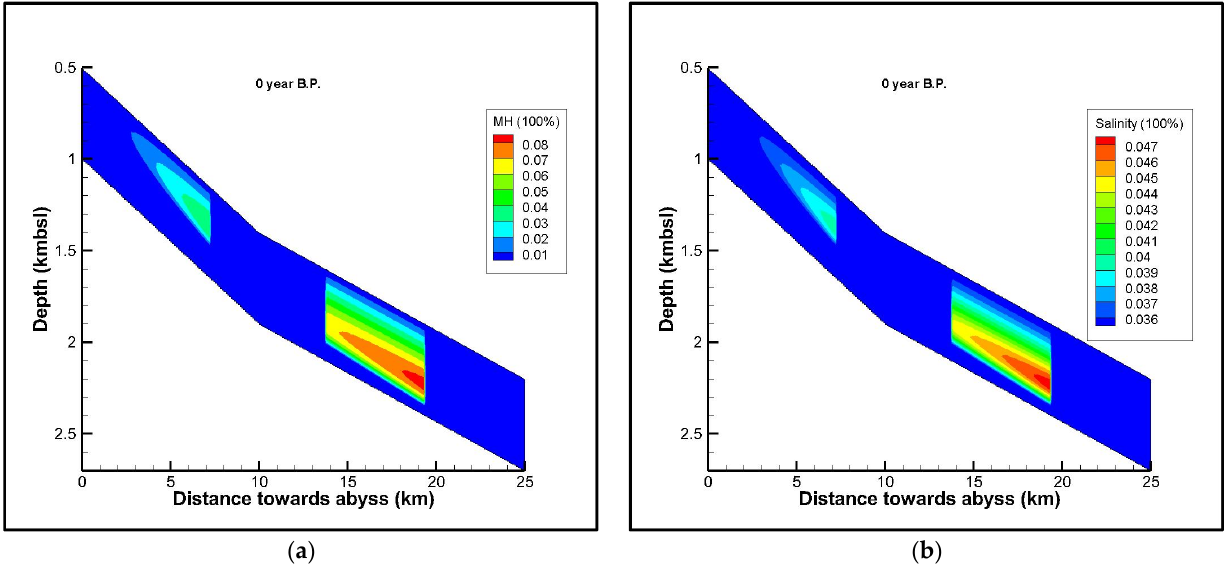
Figure 16. Appearance of MH ( a ) and salinity ( b ) from simulations by seafloor depth